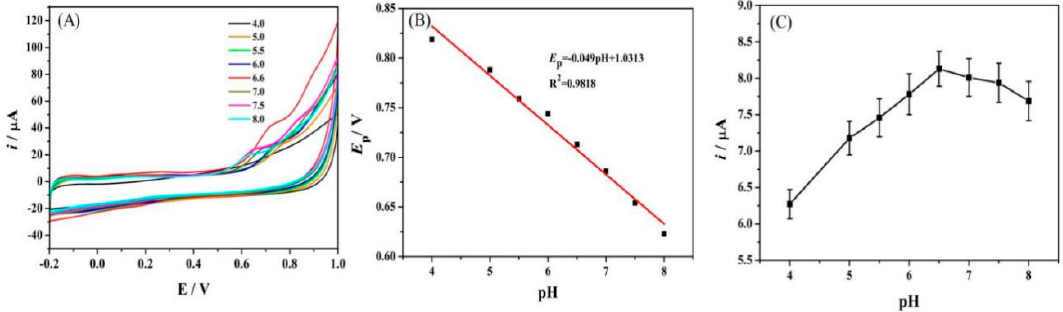
Figure 6. ( A ) CV pattern of 10 μ M oxytetracycline on Ta 2 O 5 -ErGO/GCE at different pH; ( B ) the linear relationship of the anode peak potential of oxytetracycline and the pH; ( C ) the effect of pH on the current of oxytetracycline.